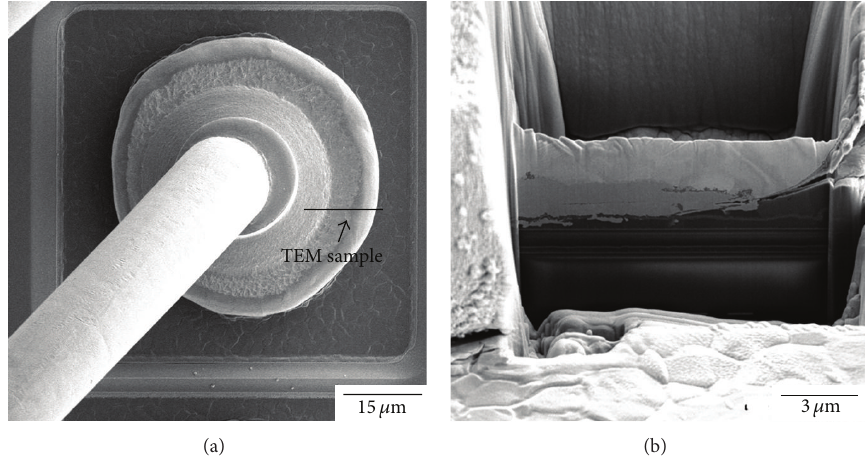
Figure 2: (a) Black line indicates the position of TEM sample by using FIB and (b) shows the shape of the TEM